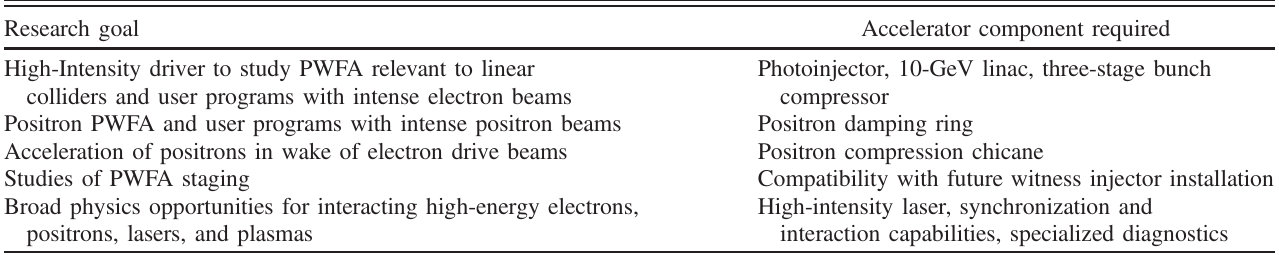
TABLE I. FACET-II summary of scientific motivations, performance goals, and design choices. Research